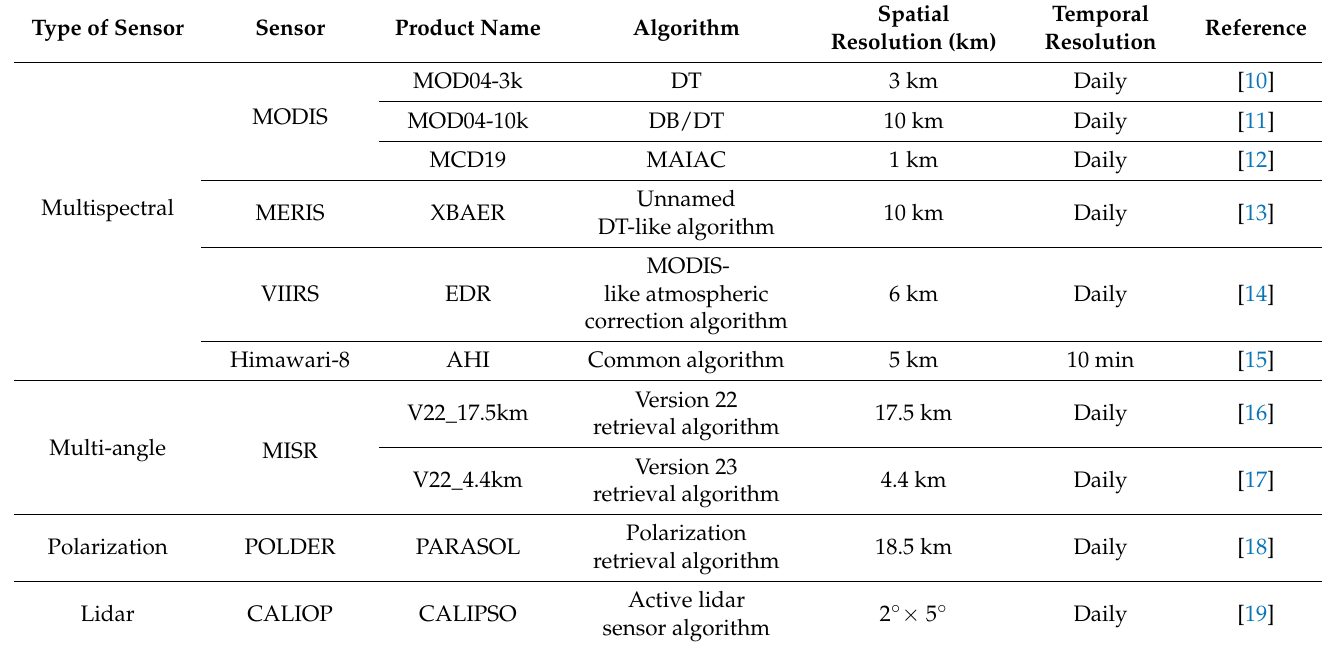
Table 1. Current remote sensing-based aerosol optical depth (AOD) instruments grouped by the type of satellite sensors